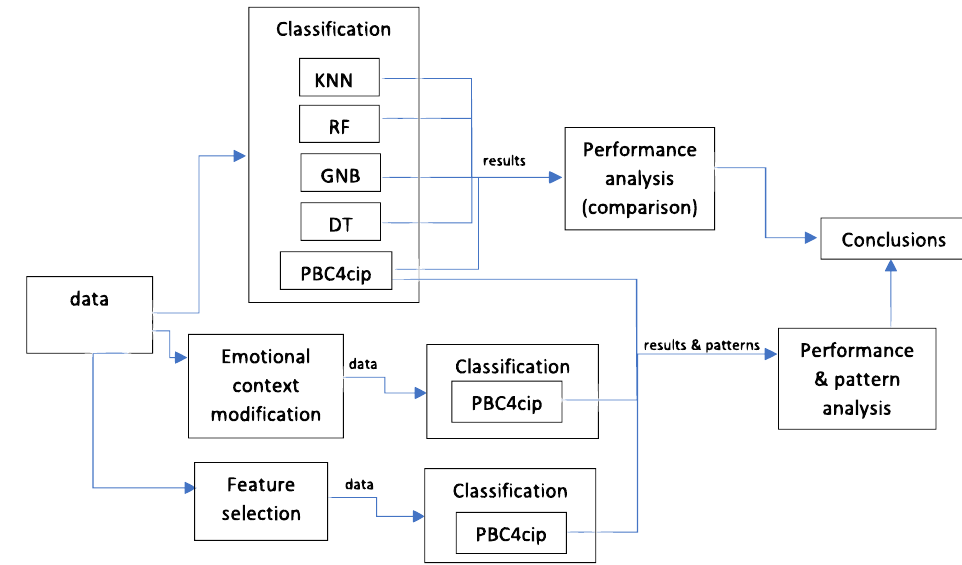
Figure 6. Data flow in the experiments carried out.